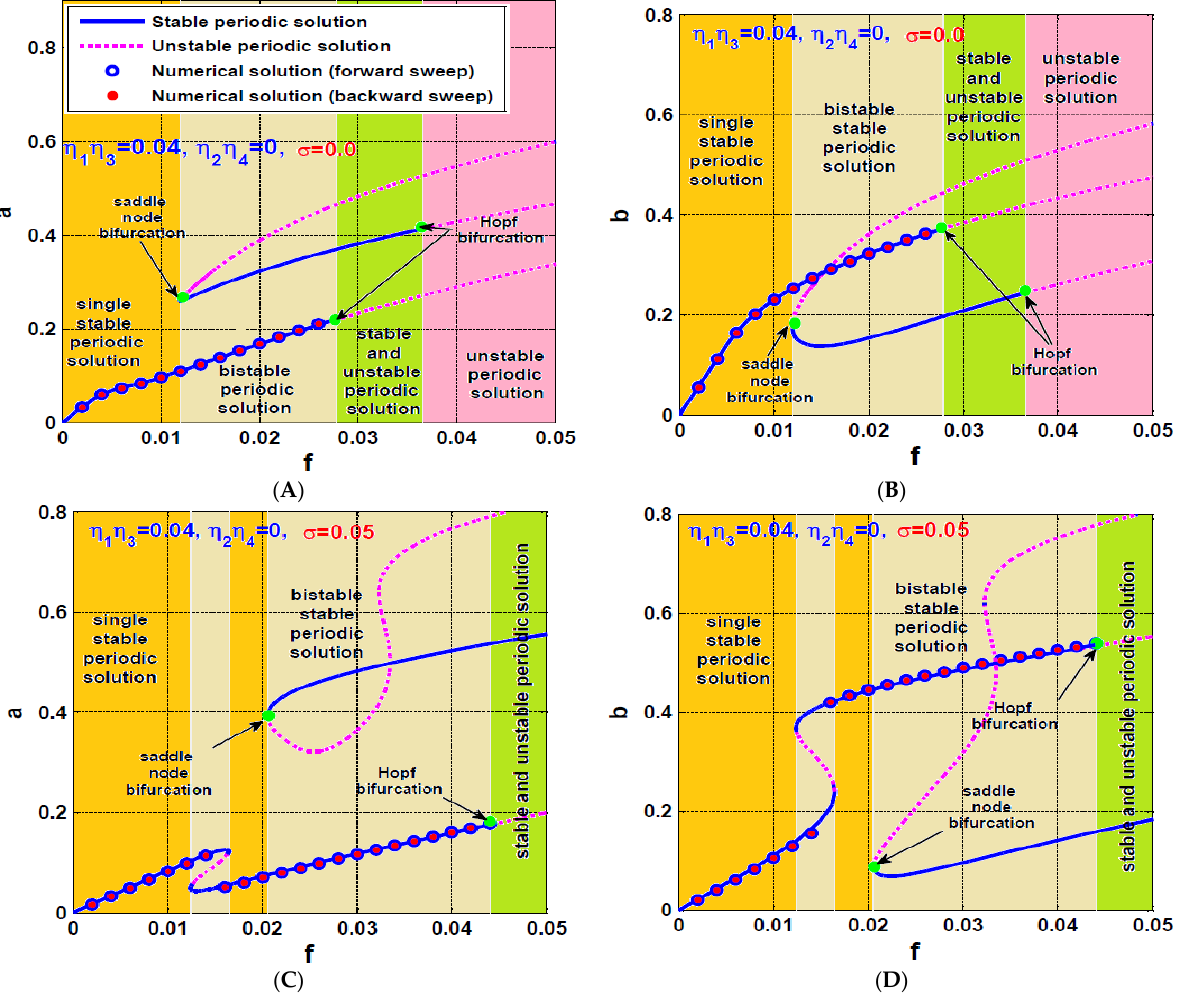
Figure 9. The rotor system 𝑓— response curve at two different values of the rotor spinning speed ( Ω = 𝜔 + 𝜎 , 𝜎 = 0.0, 0.05 ) when activating the U-IRC (i.e., 𝜂 1 𝜂 3 = 0.04 ) and turning off the V-IRC (i.e., 𝜂 2 𝜂 4 = 0.0 ): ( A , B ) the system oscillation amplitudes a and b when 𝜎 = 0.0 , and ( C , D ) the system oscillation amplitudes a and b when 𝜎 = 0.05 .